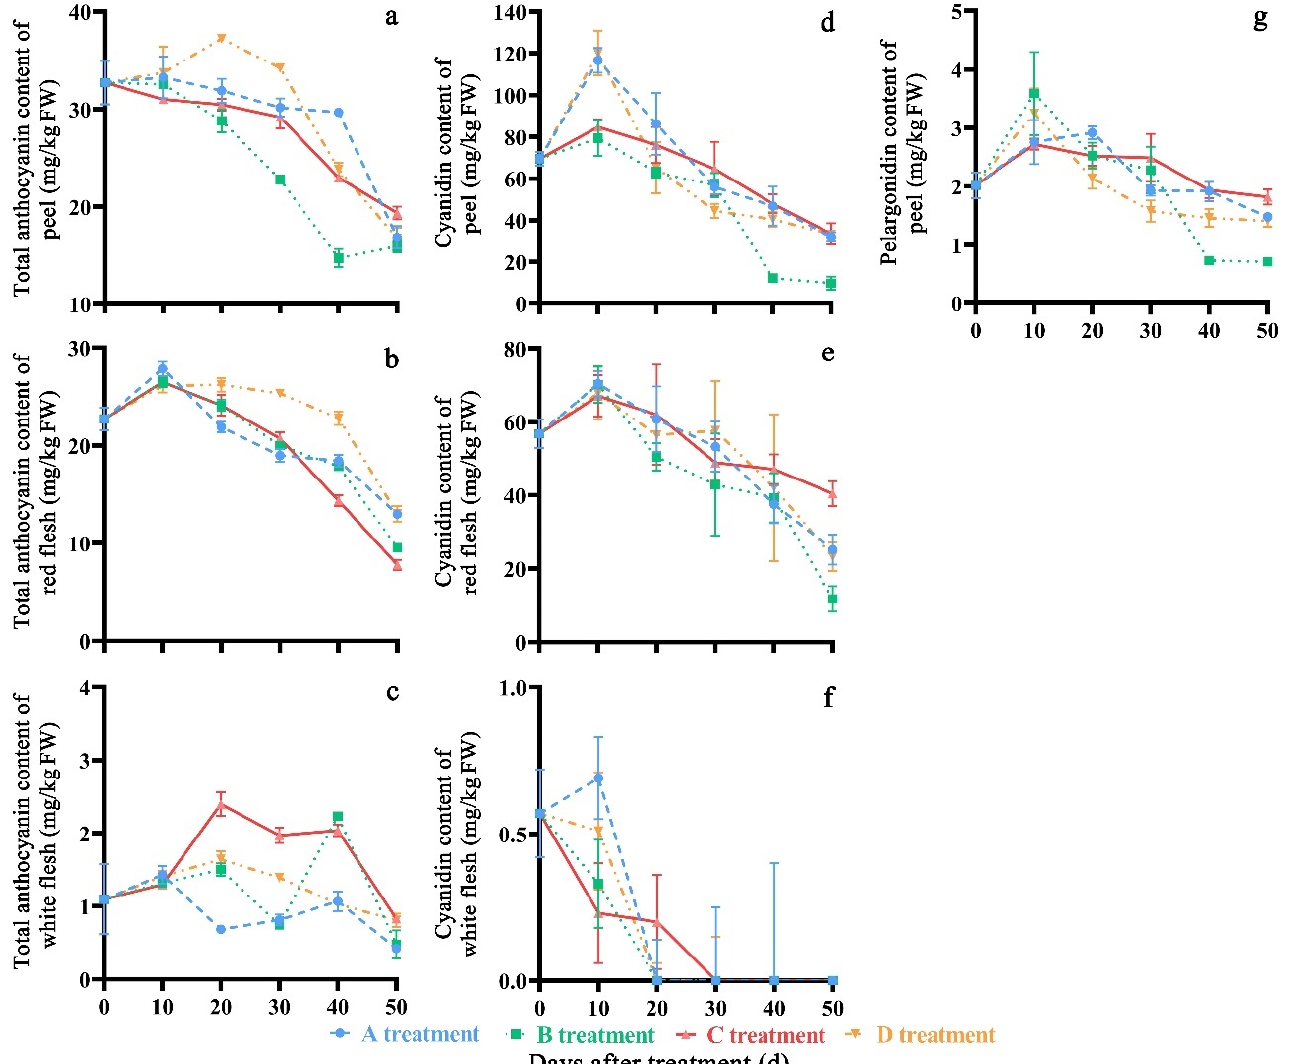
Figure 7. Changes in total anthocyanin ( a – c ), cyanidin ( d – f ) and pelargonidin ( g ) content of ‘Yonglian No.1’ peach fruits during storage in four treatments. Vertical bars represent the standard errors. The different lower case letters at each time point indicate significant difference at p < 0.05 using Duncan’s multiple range tests.